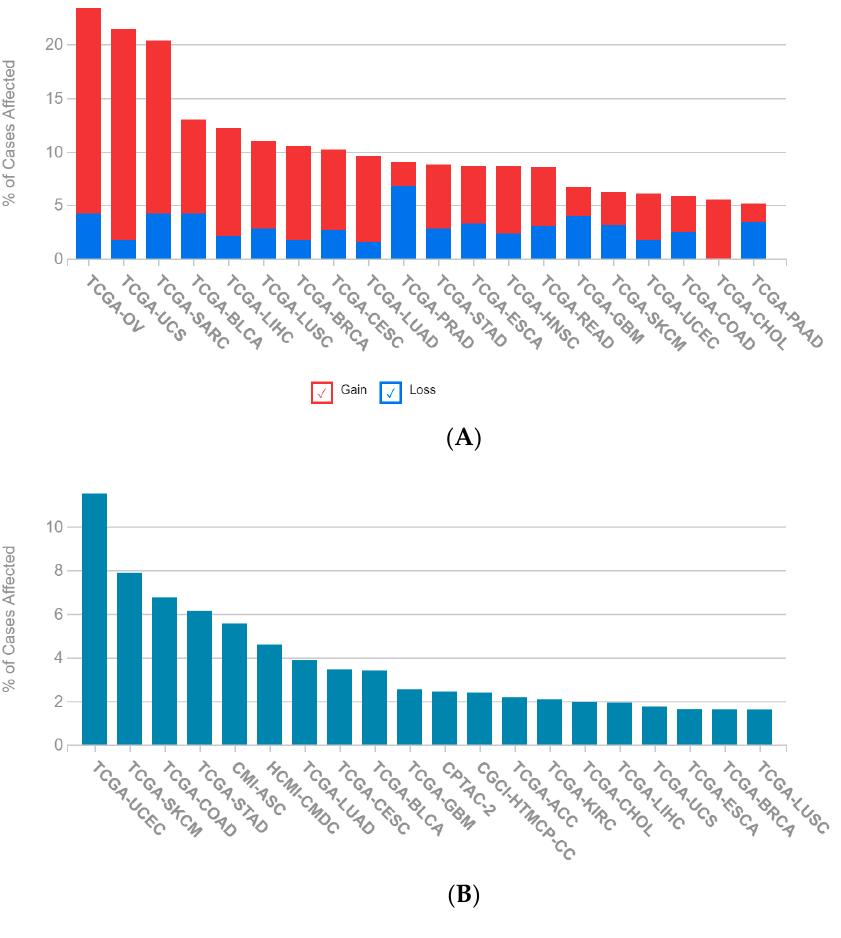
Figure A1. CNV and mutation distribution of ABCC4 in different cancer types. ( A ) CNV distribution. ( B ) Mutation distribution.